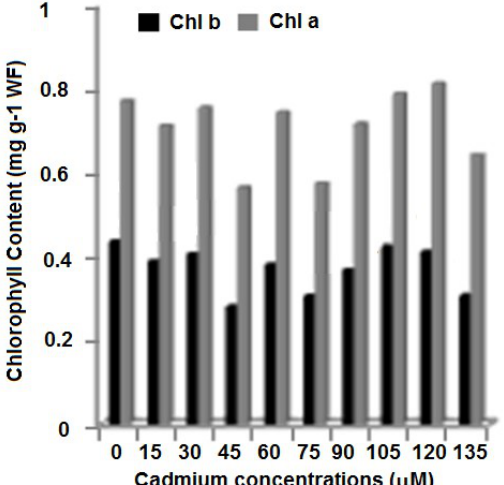
Fig. 8 . Effects of cadmium on chlorophyll a and b content of Brassica napus L.